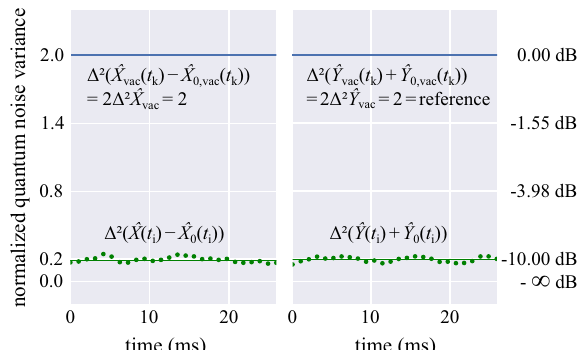
Fig. 3 Variances of our X ( t i ) data and Y ( t i ) data. Shown is the ^ X ð t Þi ¼ h ^ Y ð t Þi ¼ 0 . example of stationary zero displacement, i.e. h Solid lines correspond to the variance of 2600 measuring points each, without entanglement (top lines) and with entanglement (bottom lines). The latter represents 10 dB two-mode squeezing. Dots represent variances calculated over 260 consecutive measuring points. The variances characterise the quality of our data sampling with respect to the entangled reference. The two types of modulations ( X : left panel; Y : right panel) can be measured simultaneously with an uncertainty product of Δ ð ^ X ð t i ÞÞ Δ ð ^ Y ð t i ÞÞ (cid:5) 0 : 2 violating Inequality (2) by a factor of ~10. Here, f = 5 MHz and Δ f = 20 kHz.